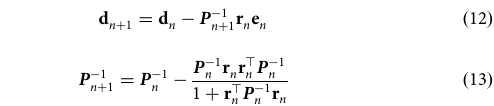
Fig. 6 Embedded switching chimera. A Schematic representation of the cortex of a bottlenose dolphin undergoing uni-hemispheric sleep, reproduced from ref. 59 : one hemisphere is synchronized (white) and the other one is unsynchronized (gray). The state of each hemisphere can change (synchronized to unsynchronized and vice-versa) due to an external perturbation (here depicted as a gray arrow). B Embedded switching chimera from the network output: the two groups (orange and purple or light and dark gray for b/w printing) change state (synchronized to unsynchronized and vice-versa) if it receives an external pulse (gray line) otherwise it does not change the state. C Individual fi ring rates of the recurrent neural network before and after the pulse (gray line). D PCA of the network's fi ring rates before and after the pulse. We plot the 1st, the 3rd and the 5th components (dark red, turquoise and yellow or black, dark and light gray for b/w printing) vs time before and after the pulse (gray 0 ⩽ ∣ z ∣ < 1. In a chimera state the oscillators of one group are complete synchro- nized while the other group is not synchronized.